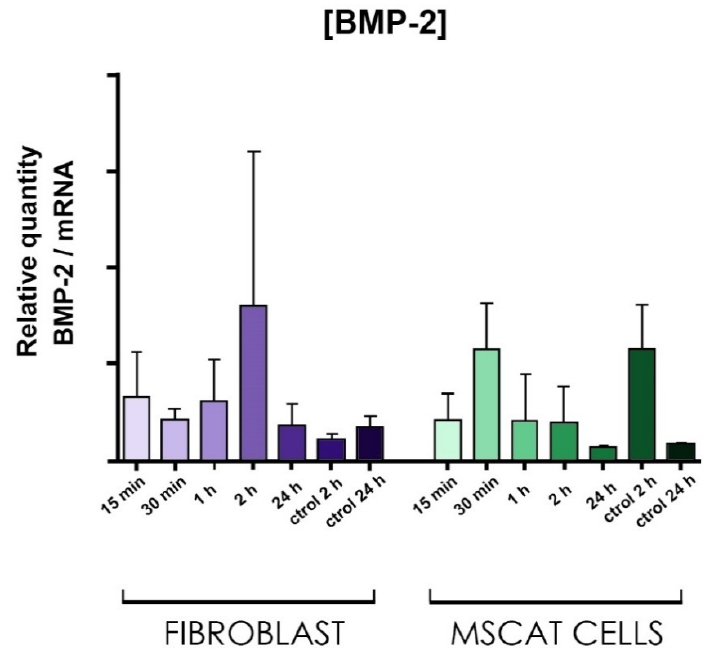
Figure 13. Graph showing the determination of messenger RNA levels for BMP-2 in fibroblast and MSCat cultures measured by q-PCR-RT at different study times: 15 min; 30 min; 1 h; and 2 h.